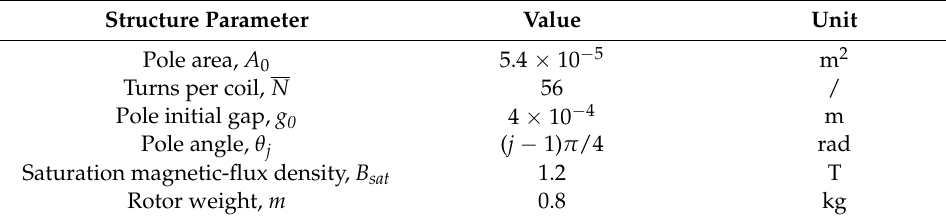
Table 1. Structural parameters of magnetic